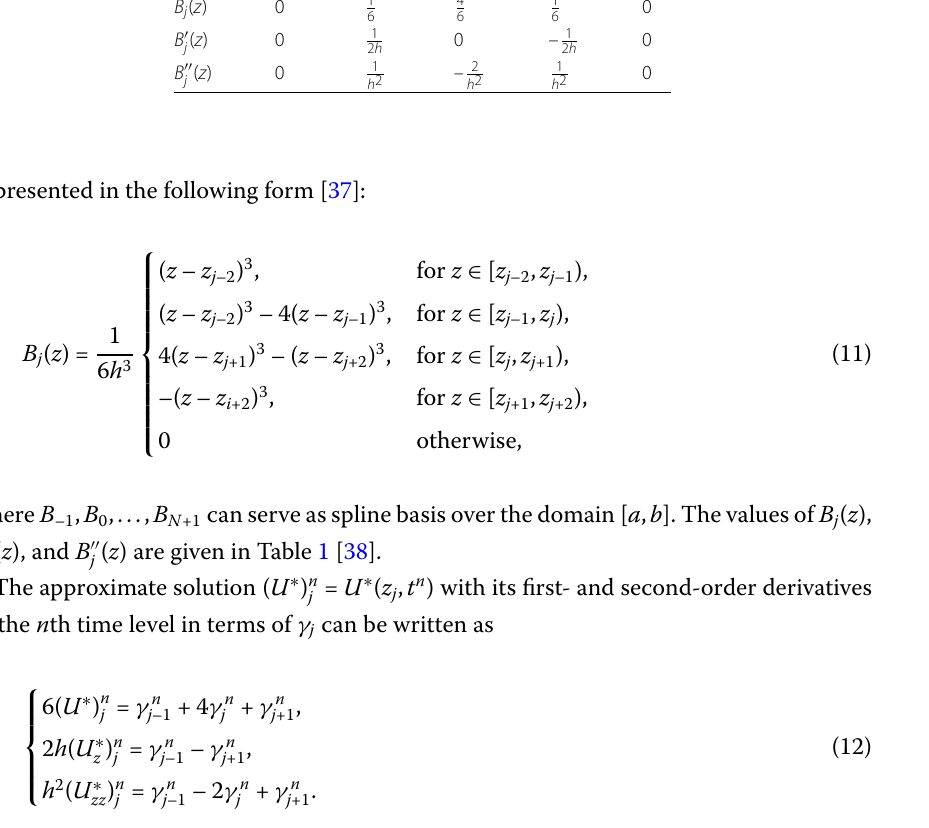
z z j –2 z j –1 z j z j +1 z j +2 B j ( z ) 0 1 B (cid:7) ( z j